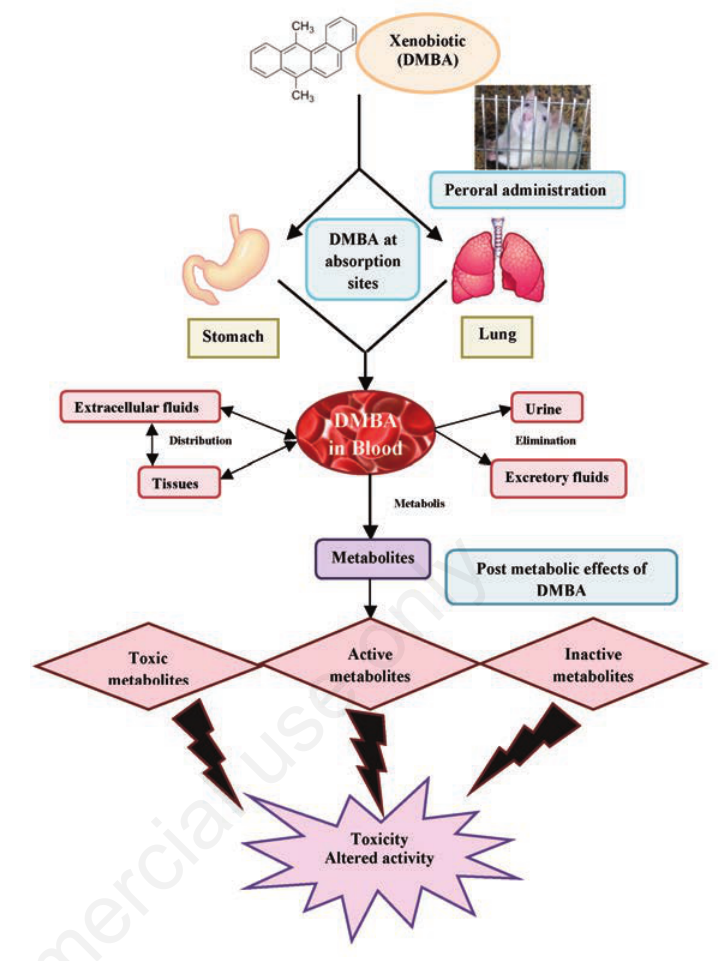
Figure 1. Schematic representation of possible fate of DMBA after administration into the